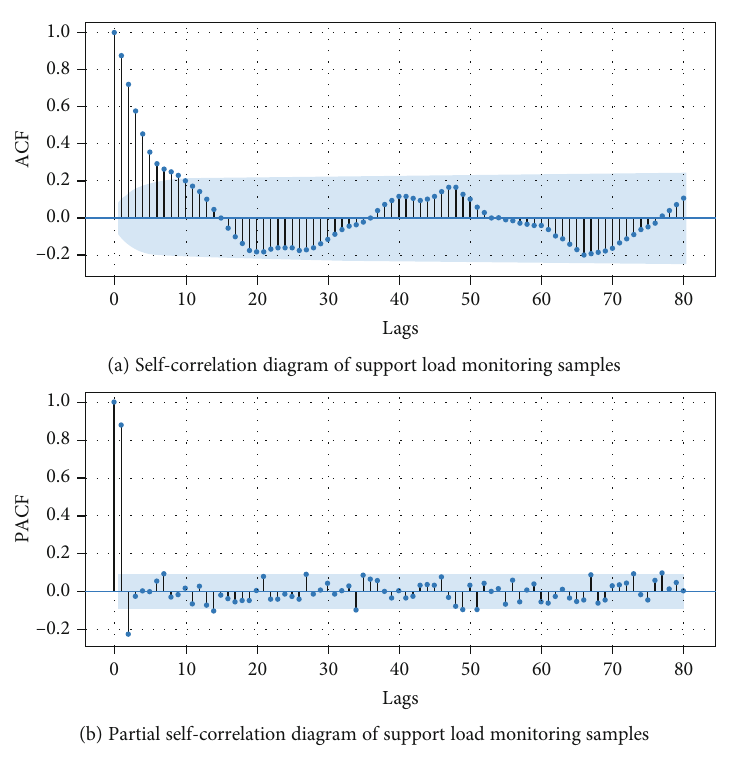
Figure 4: Self-correlation and partial self-correlation diagrams of support load monitoring samples. Table 2: Results of stationarity test after sample data